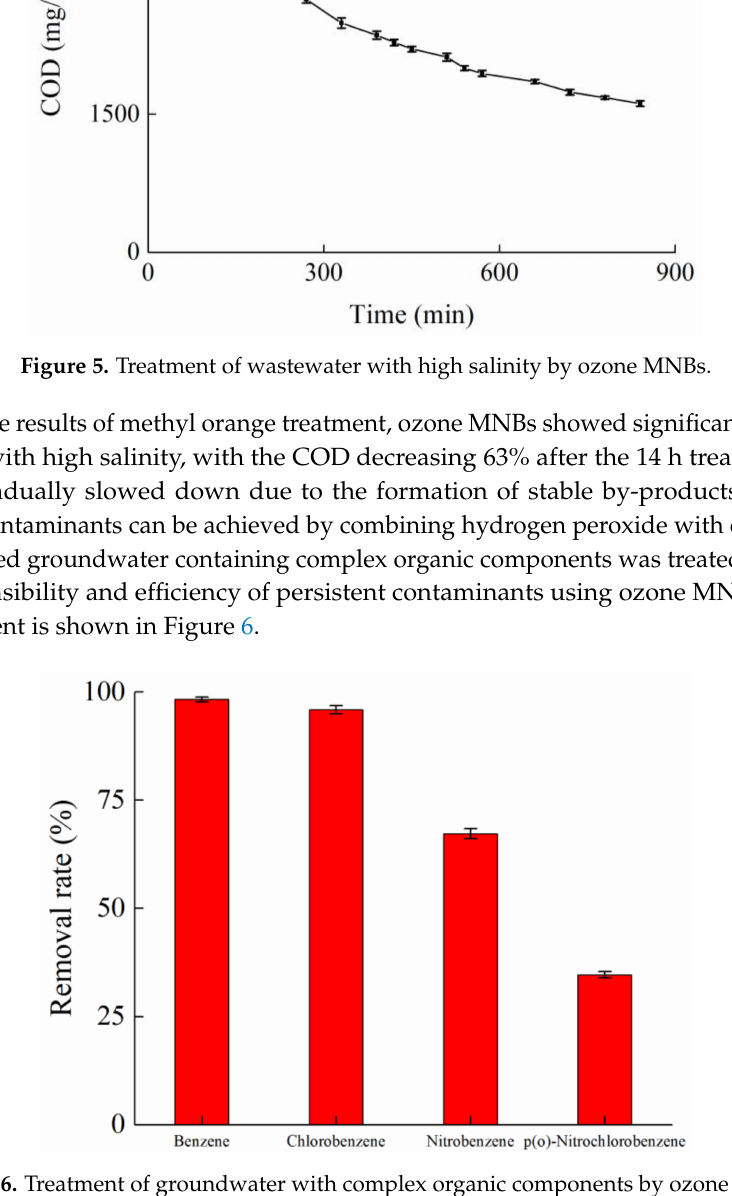
Figure 6. Treatment of groundwater with complex organic components by ozone